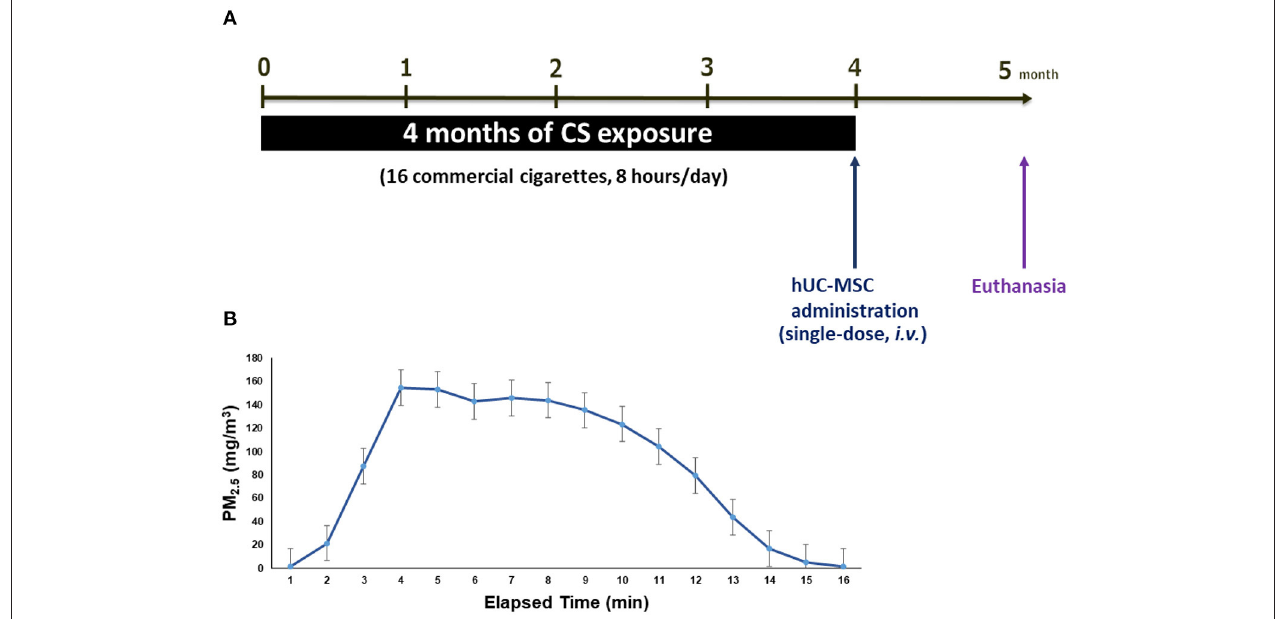
FIGURE 1 | (A) Schematic mice model of cigarette smoke (CS)-induced emphysema. (B) The distribution of particulate matter with an aerodynamic diameter of < 2.5 µ m (PM 2.5 ) mass concentration in the whole-body exposure system (mean ± SD). Mice (8 weeks old, 20–25g, n = 8–10 per group) were exposed to CS for